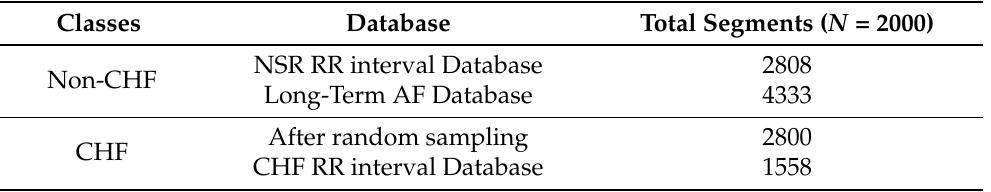
Table 4. The number of ECG recordings in each dataset when the segment length N = 2000.